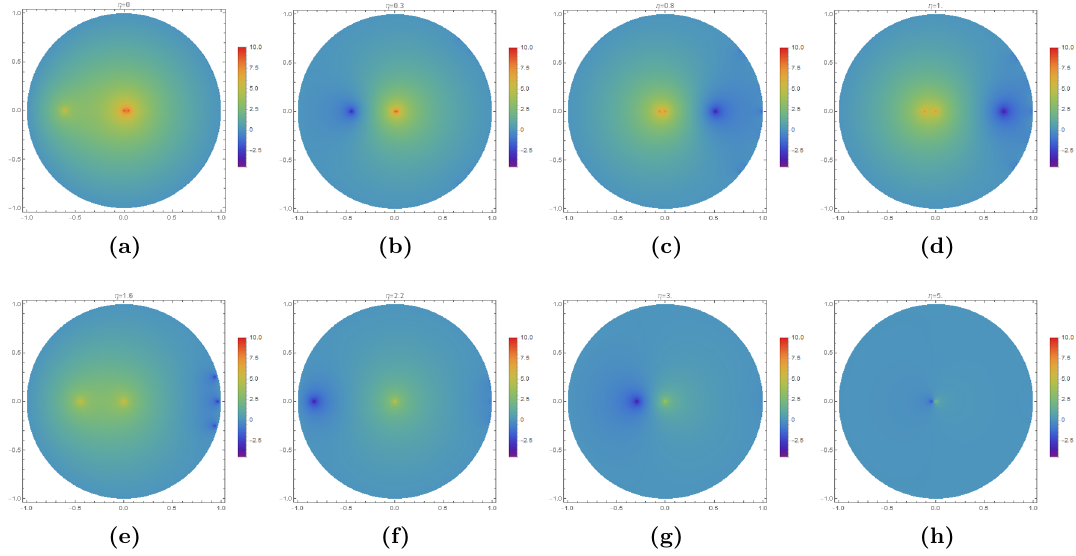
Figure 12. The approximation for log | S ( z ) | on the z -disc, for various η values between 0 and 5, obtained using method II of section 2.2 (error bounds not shown). At each value of η , we have assumed a certain number of CDD zeros in the fitting, similarly to figure 10. For η > 0 , one zero on the real z -axis is assumed (this is presumably the resonance z 0 for 0 < η ≤ 1 . 6 and z 0 for η > 2 ). 3 2 For η ≤ 1 . 8 , we include two pairs of complex CDD zeros and fit their positions. As shown in more detail in figure 15, the existence of one of the complex zeros z 0 is justified rigorously by the error 4 bound, and is interpreted as the resonance coming from the particle of mass m 4 at the E 8 point. The interpretation of the other complex zero z 0 is unclear. Note that the z 0 and z 0 resonances are x x 4 not visible in most of the plots due to their proximity to the boundary, except in the η = 1 . 6 case where z 0 is clearly x